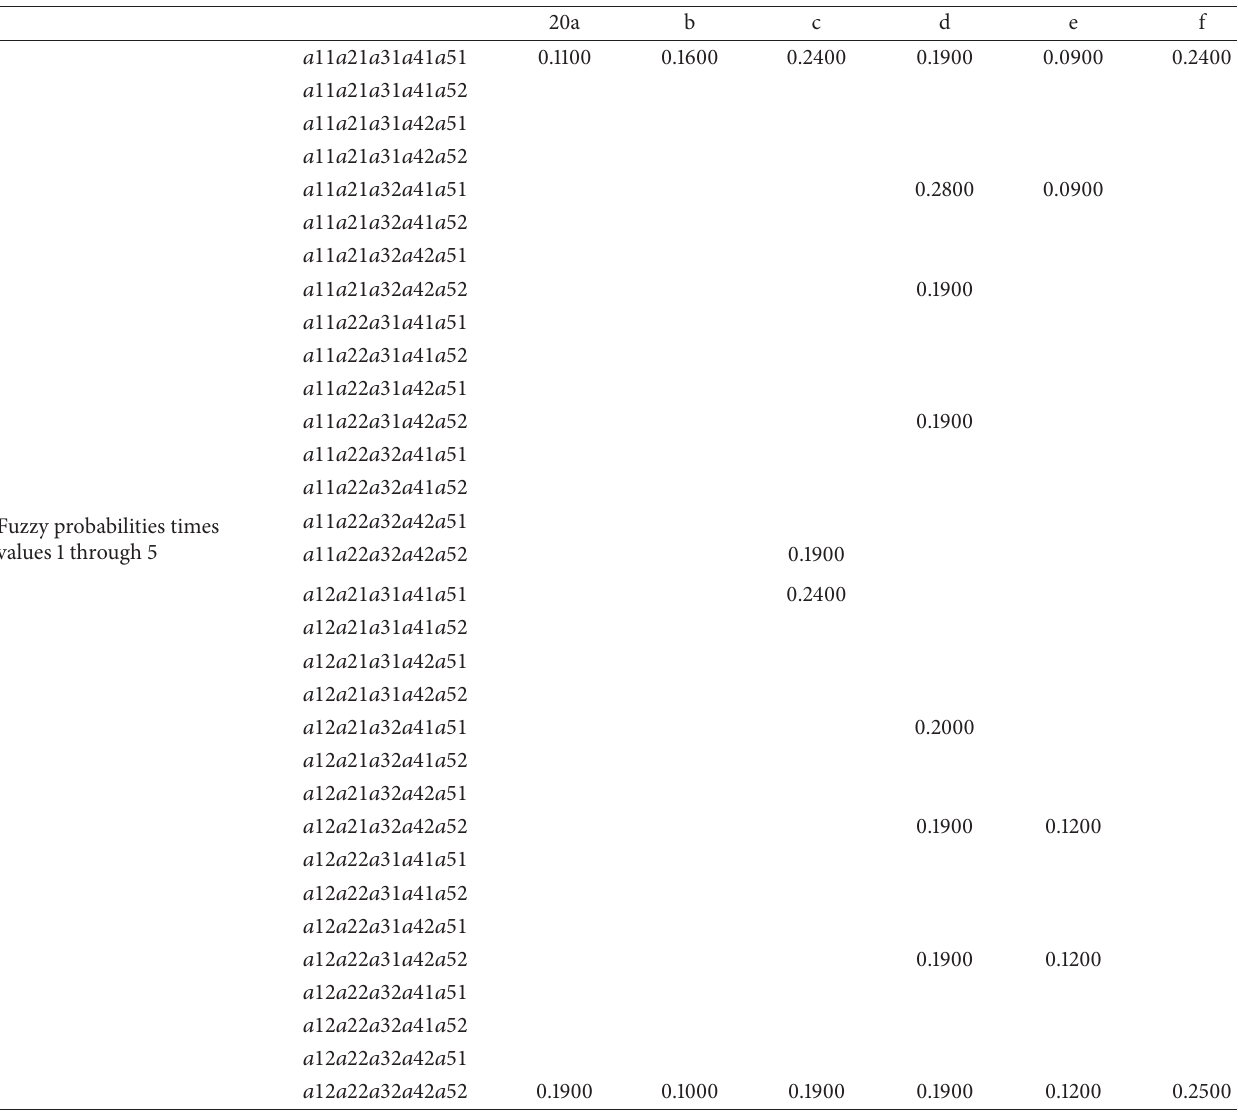
Table 6: Minimum beliefs for Question 20 for each usable